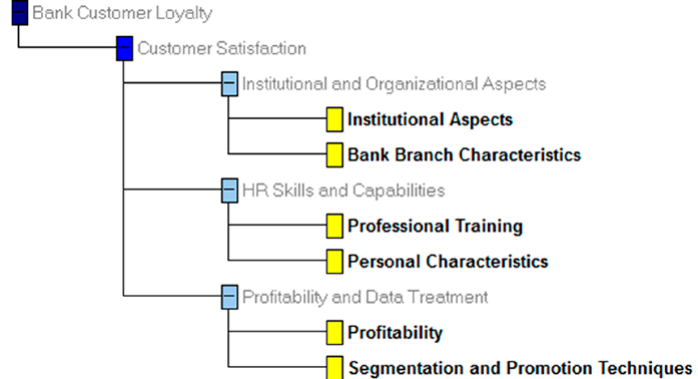
Fig. 2. Tree of points of